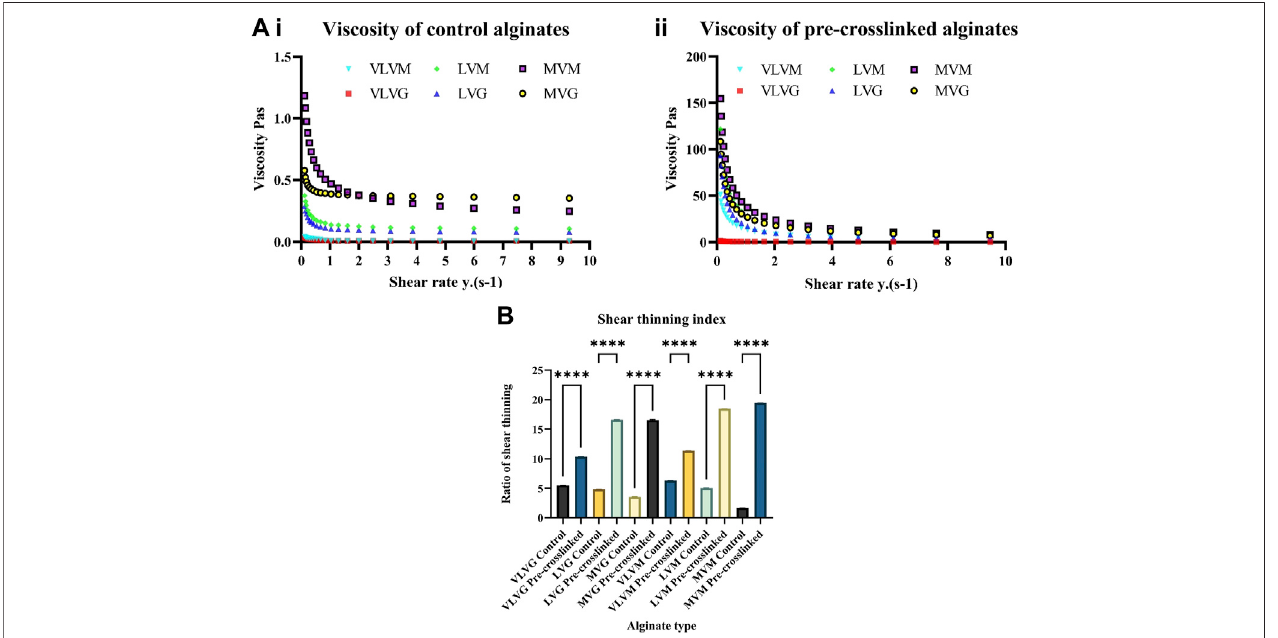
FIGURE3 | Effect ofCaSO 4 pre-crosslinking on alginate-based bio-ink viscosity.Assessmentof viscosity ofcontrol (Ai) and pre-crosslinked (Aii) alginate bio-inks was performed using a rotational rheometer. Shear thinning index was calculated by dividing apparent viscosity at the lowest speed by the apparent viscosity at the highest speed (B) . Values are expressed as mean ± SD from six separate experiments with asterisks representing signi fi cance from control values (****, p <